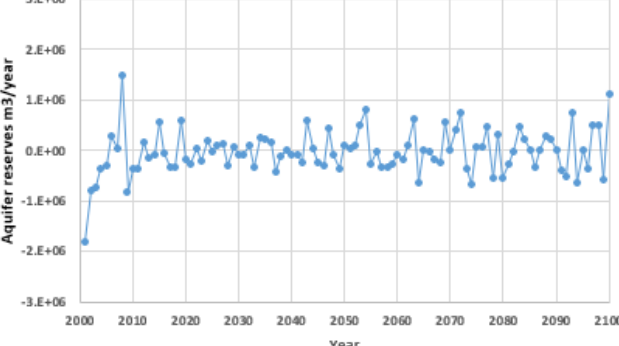
Figure A12. Piezometric variations at wells Pk9 and Pk6 from 2001 to 2100 under scenario RCP 8.5.